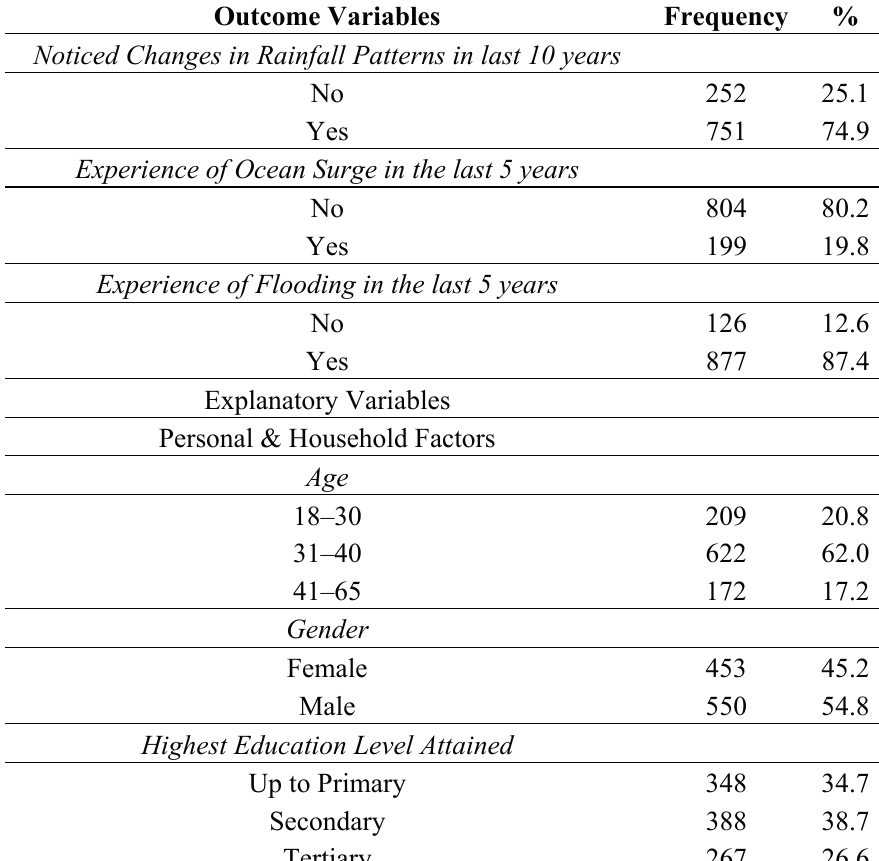
Table 1. Descriptive statistics of outcome and explanatory variables ( n =